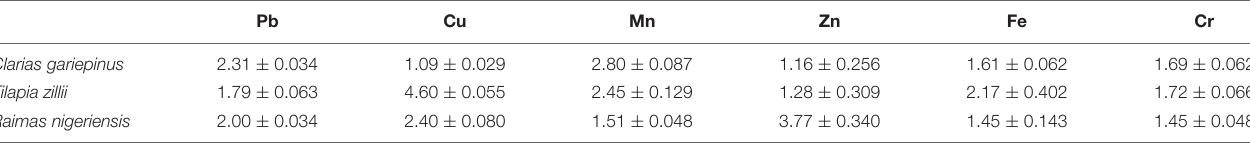
TABLE 5 | BAF for the analyzed metals in parasites and fish tissues of Clarias gariepinus, Tilapia zillii, and Raimas nigeriensis. Pb Cu Mn Zn Fe Cr Clarias gariepinus 2.31 ± 0.034 Tilapia zillii Raimas